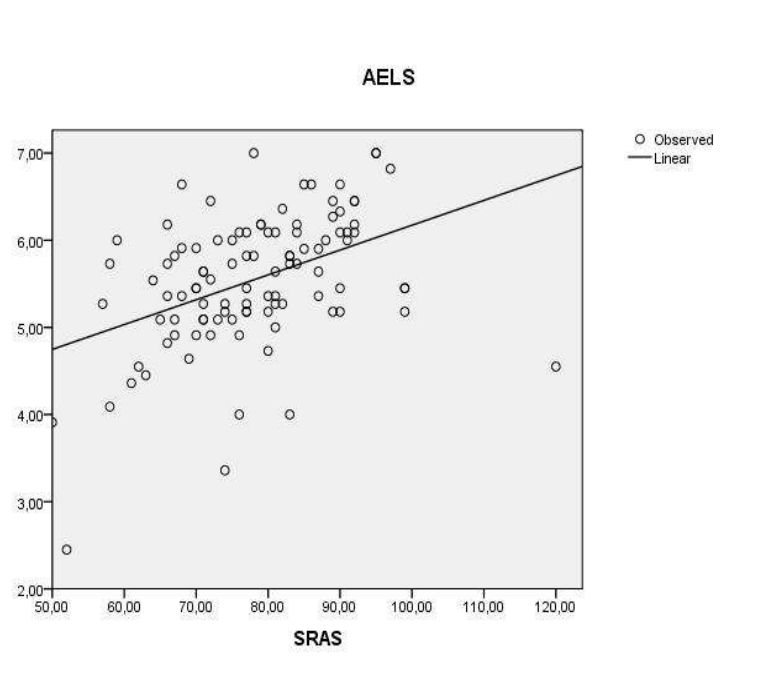
Figure 2 . Mean increase of self-reported altruistic behavior (SRAS) predicted mean increase of active- empathic listening (AELS), n =